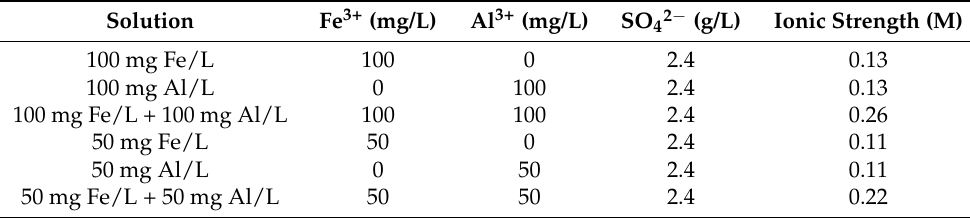
Table 1. Synthetic acid drainage solutions